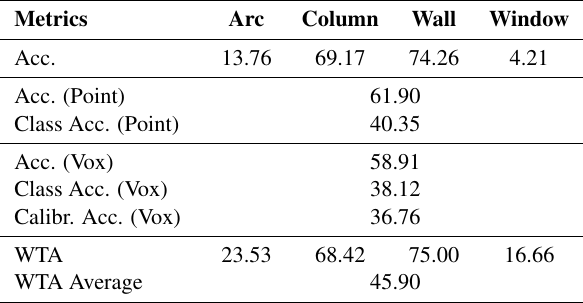
Table 2. Accuracy for each class considering metrics based on points, based on Voxels and WTA technique.